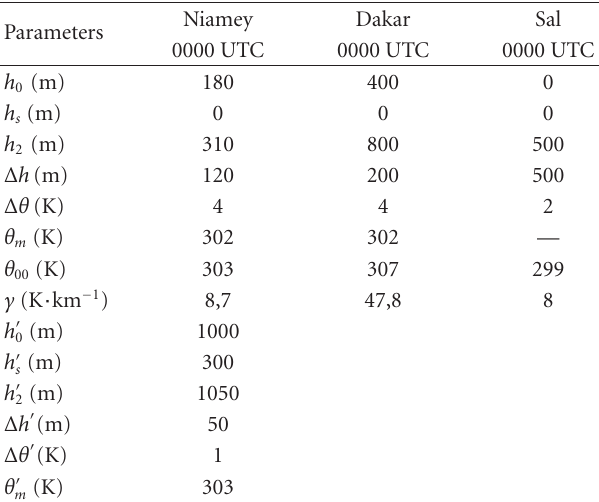
Table 4: Characteristic parameters of the continental boundary layer (Niamey), coastal (Dakar), and marine (Sal) at 0000 UTC for case